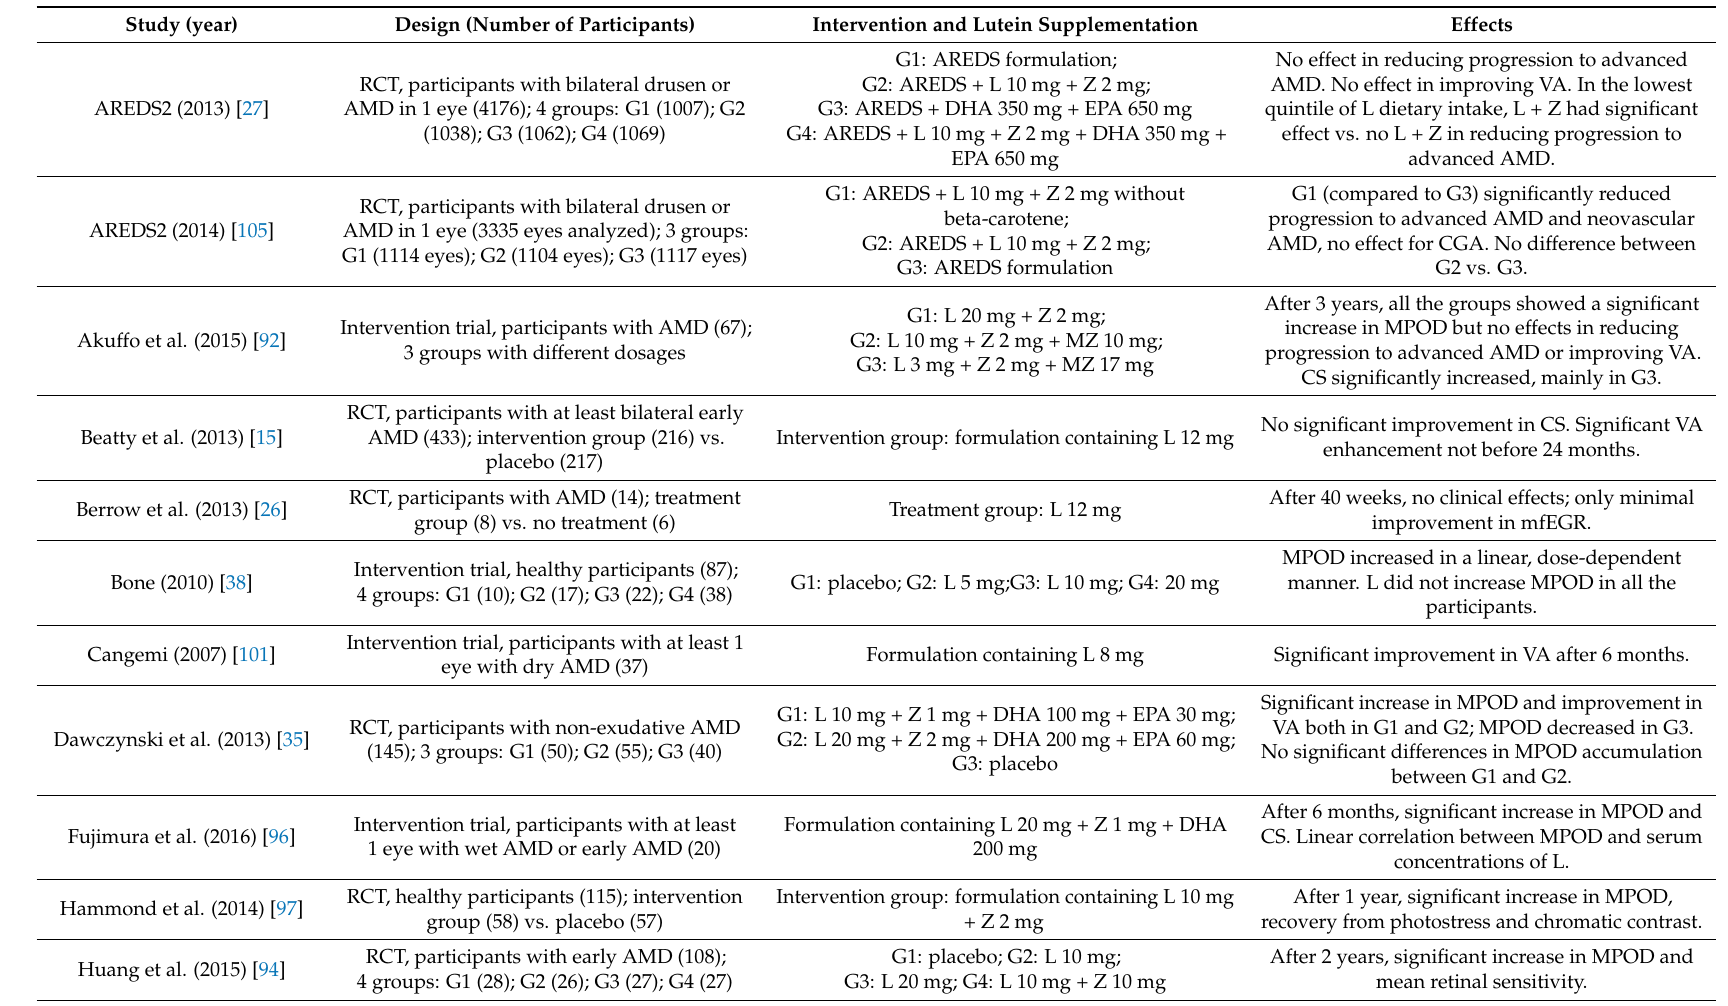
Table 2. Intervention studies on the effects of lutein on visual